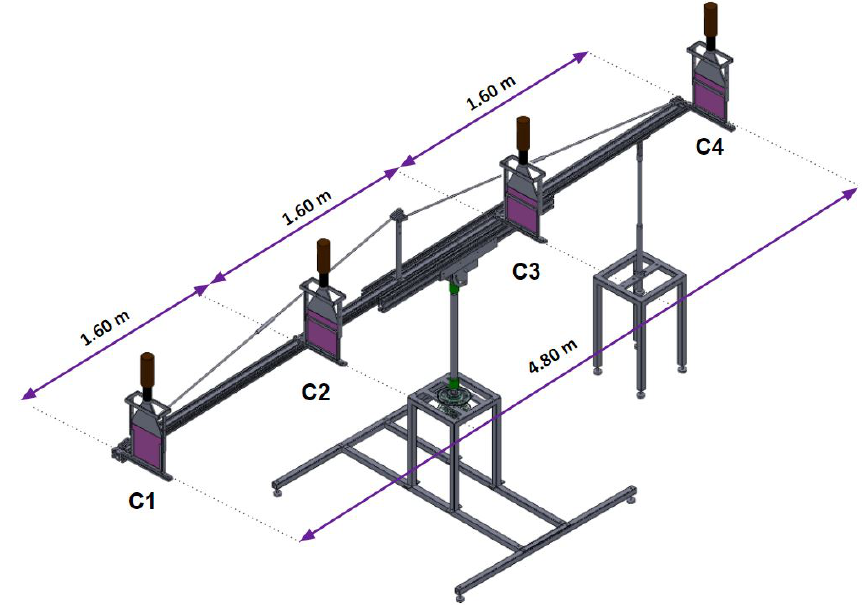
Figure 1. Layout of the telescope structure. The detectors are located equally